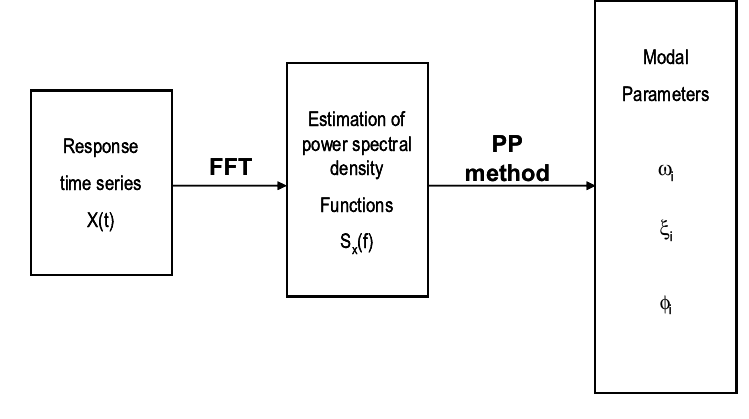
Fig. 5. Schematic representation of output-only modal identification.